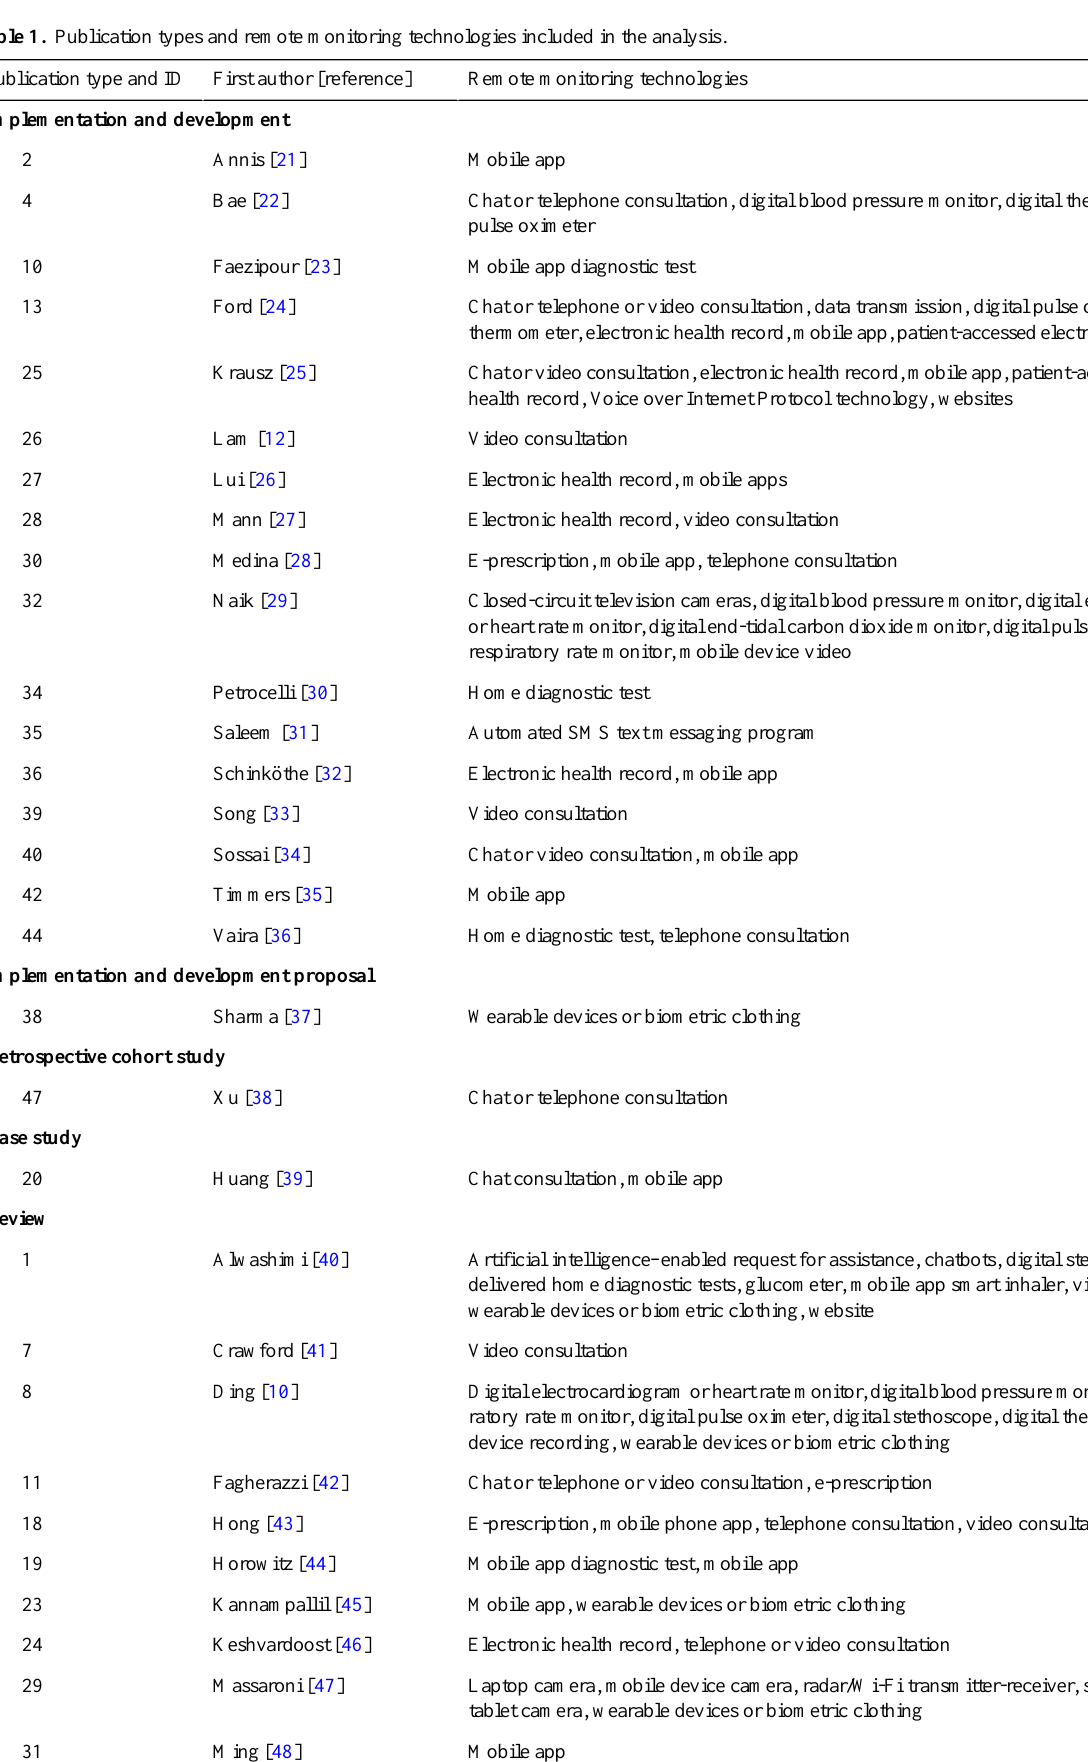
Table 1. Publication types and remote monitoring technologies included in the analysis. Implementation and